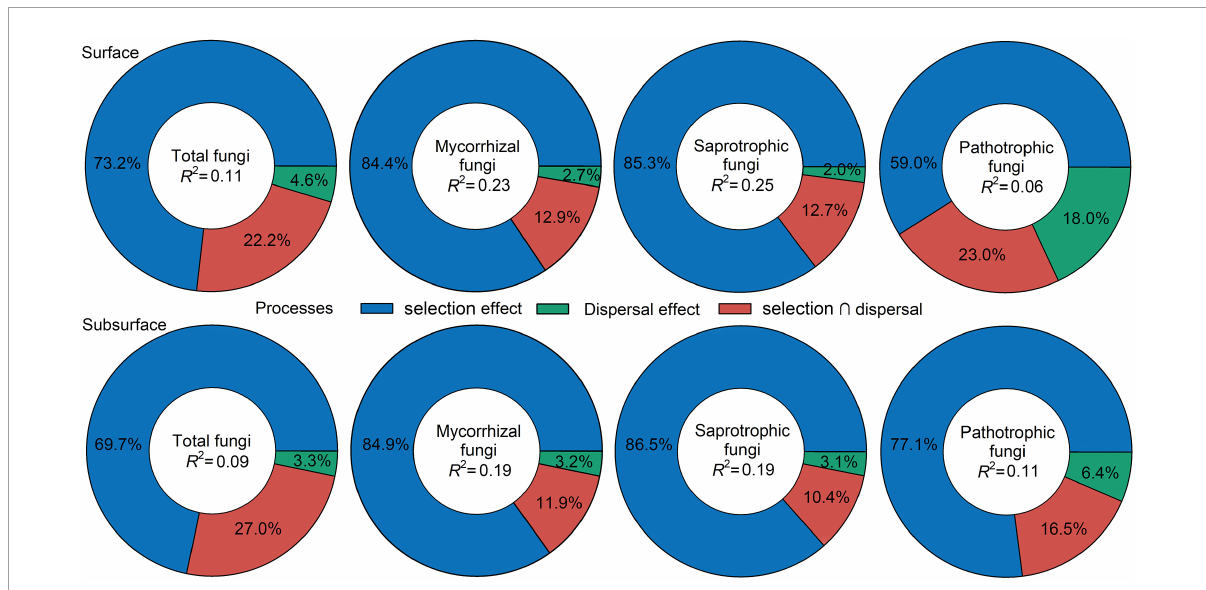
FIGURE2 Summary of the relative effects of environmental selection, dispersal limitation and their interaction derived from the variation partitioning